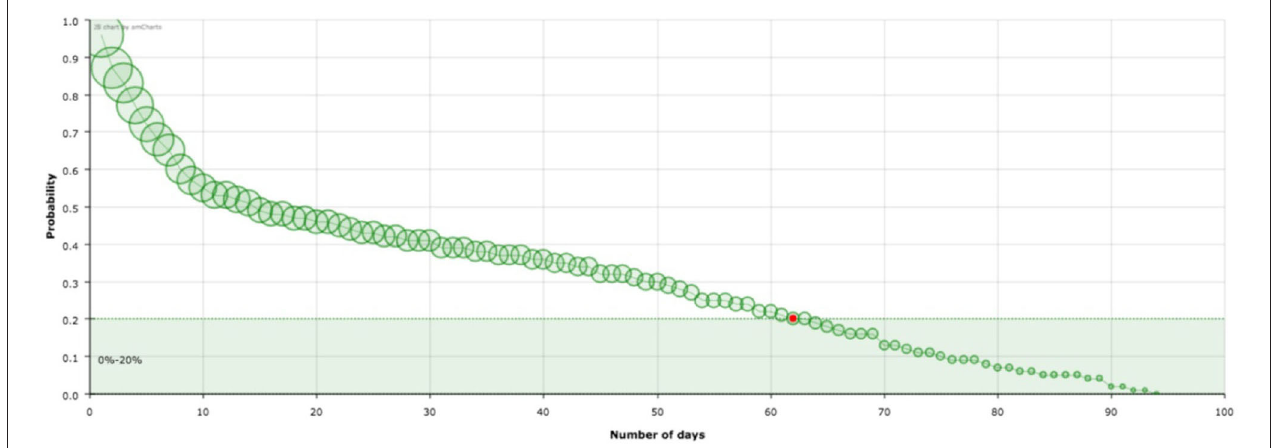
FIGURE 1 | Survival curve, S , of the virus corresponding to Spain. The red point signs the number of days after which a standard individual has a probability of staying in the group of infected people smaller than 0.2. This value has been arbitrarily set as an aid to the visualization of the decreasing of the curve. The size of the balls is proportional to their value at the